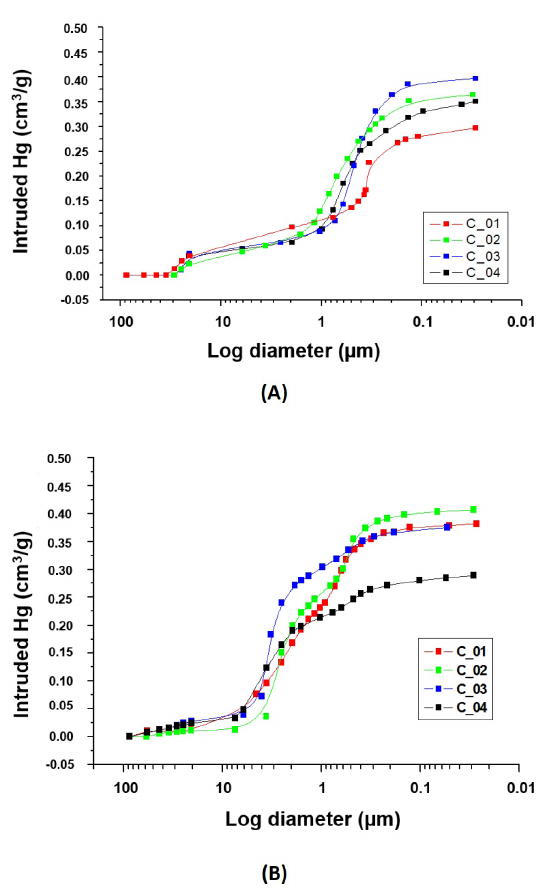
Figure 11. Pore size distributions of the magnesium phosphate cements prepared from MgO powders calcined at (A) 900 °C / 2 h and (B) 1100 °C / 2 h, with different MgO/NH mass, with a water content of